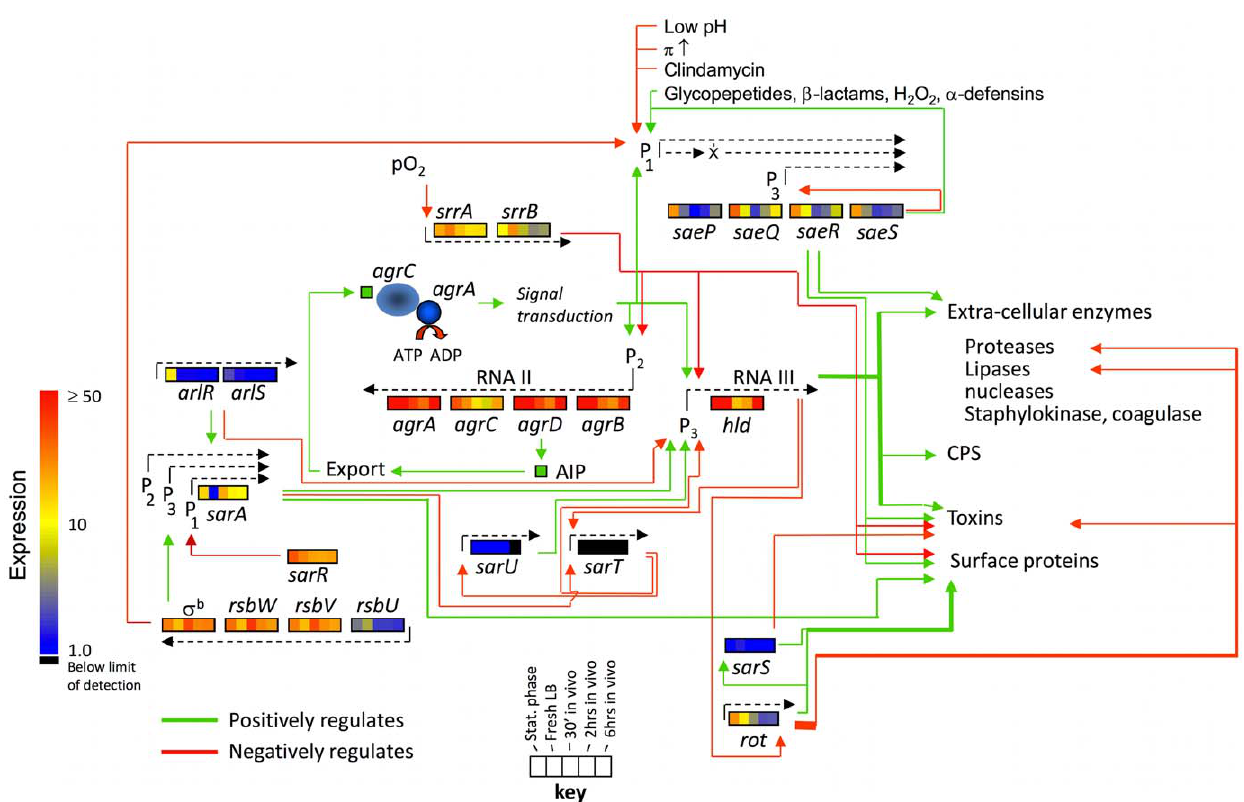
Figure 8. Expression of virulence regulators. Schema of the S. aureus virulence regulatory network based on the current understanding of the interrelationships between regulators. Transcriptional changes seen in strain JP1 during adaptation to the mouse airway are shown for each gene. Green and red lines indicate positive and negative regulation, respectively, between interacting regulators. The color scale on the left indicates transcriptional activity for each gene; a key for the gene expression by growth condition is shown on the bottom center of the figure. Transcriptional units are shown as dashed lines above or below the operons originating at their respective promoters. Where operons have multiple promoters, the regulator acting at the specific promoter is diagrammed. Osmotic pressure is indicated by the symbol p . The RNAII and III transcripts are shown as dashed lines above their respective operons.